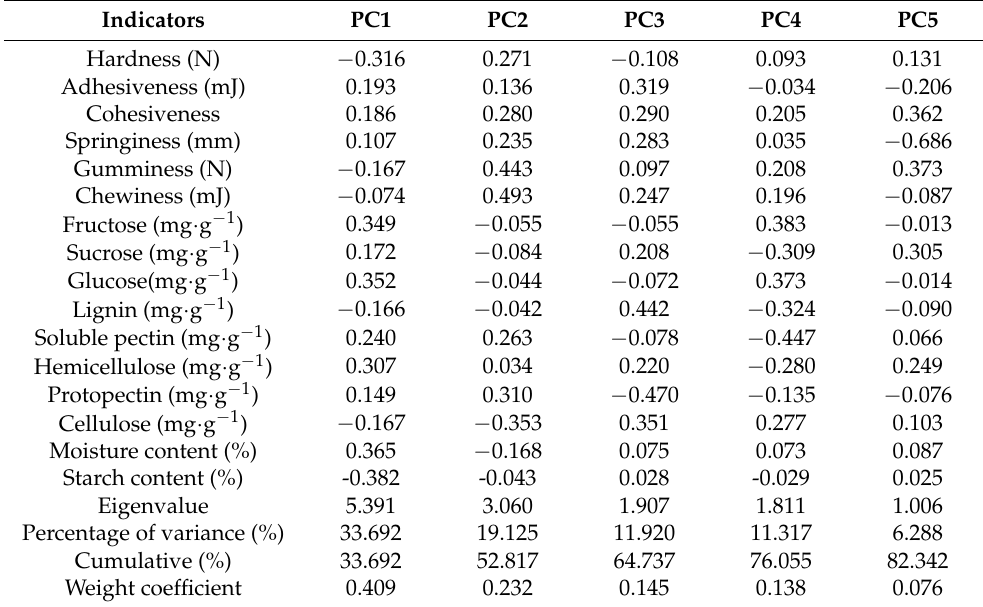
Table 3. Eigenvectors of corresponding matrices for tuberous root quality traits of sweet